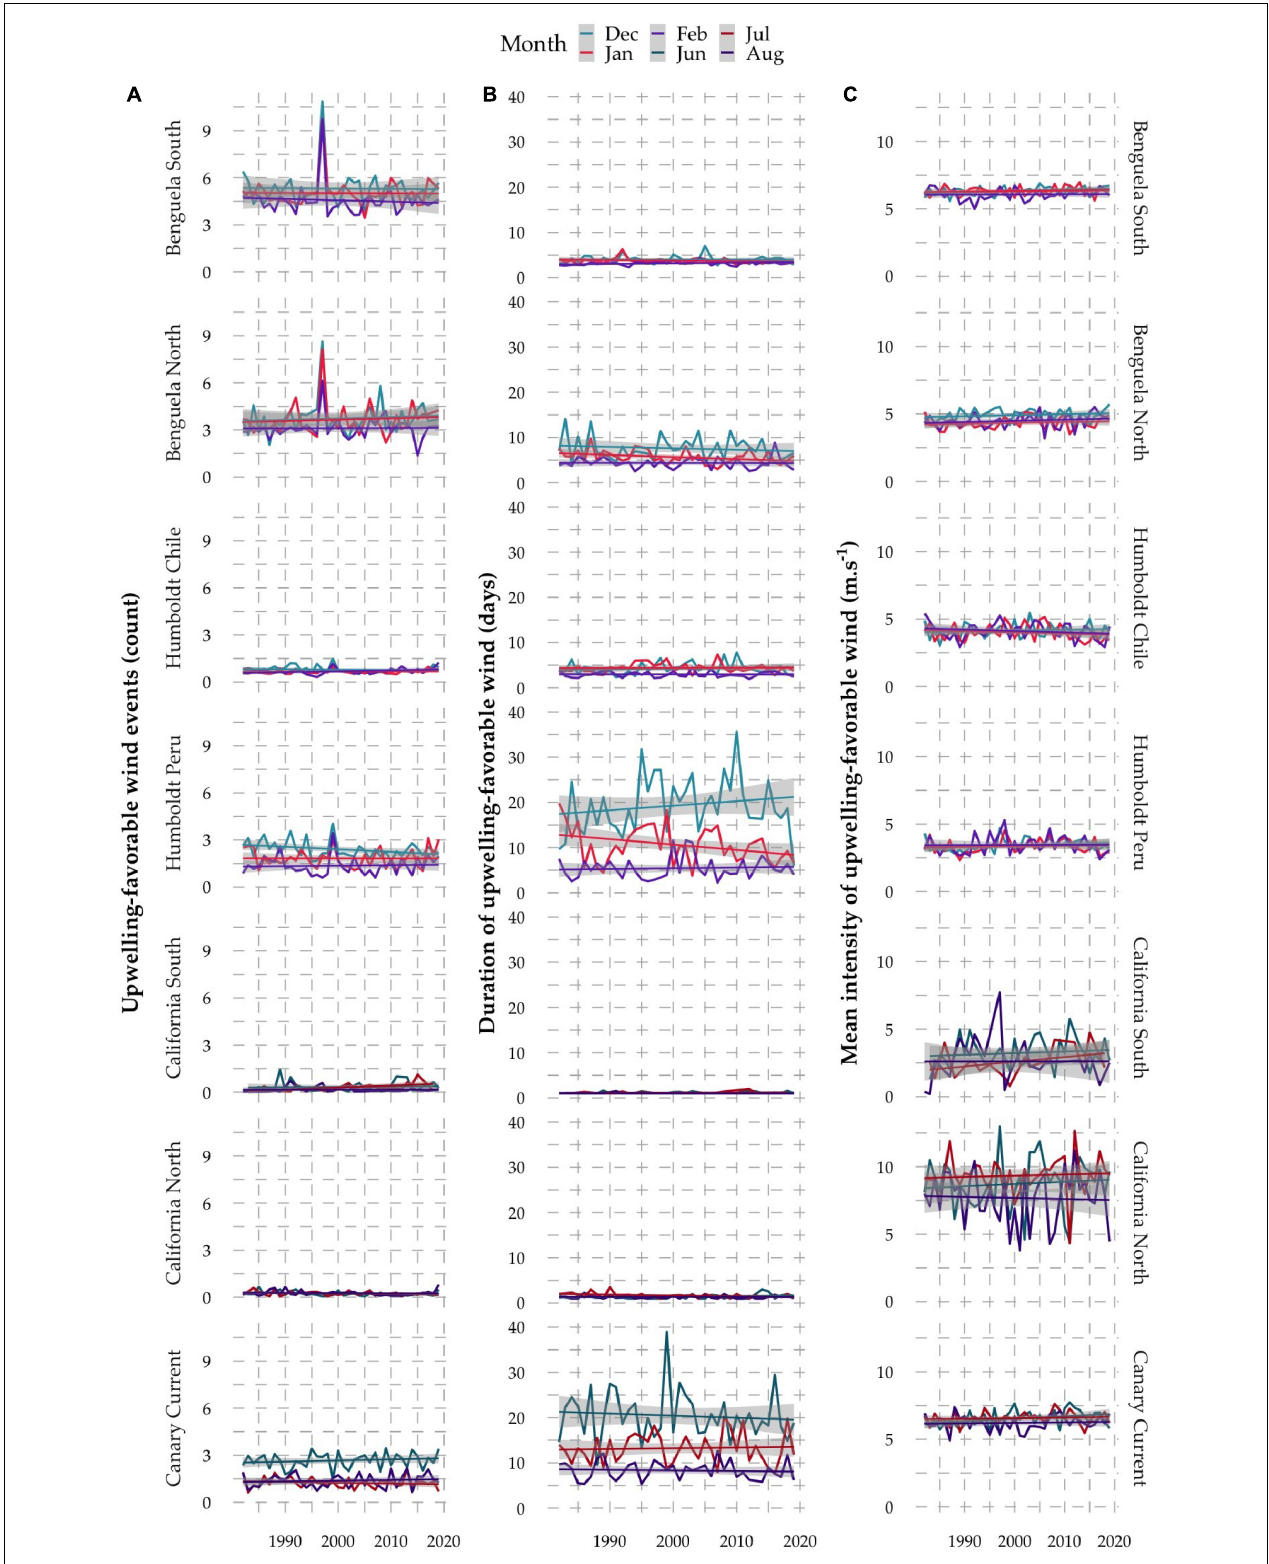
FIGURE 3 | Count (A) , duration (B) and mean intensity (C) of upwelling-favorable winds during austral (DJF) and boreal (JJA) summer months over a period of 37 years.